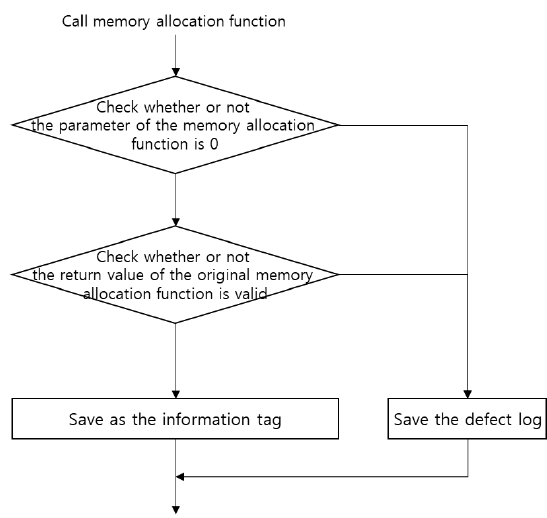
Figure 6. Real-time defect-detection: memory allocation.